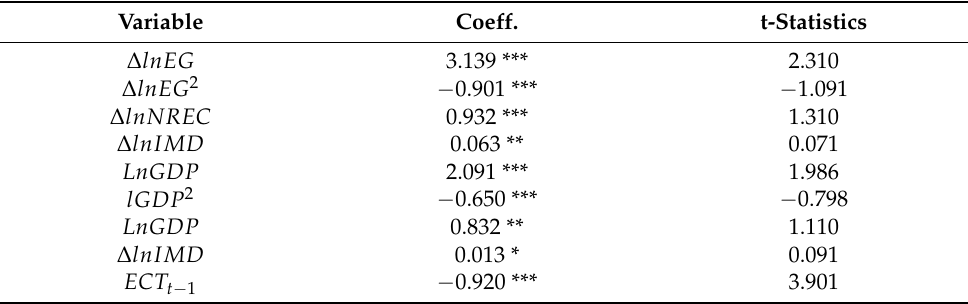
Table 5. Findings of ARDL in the short run.